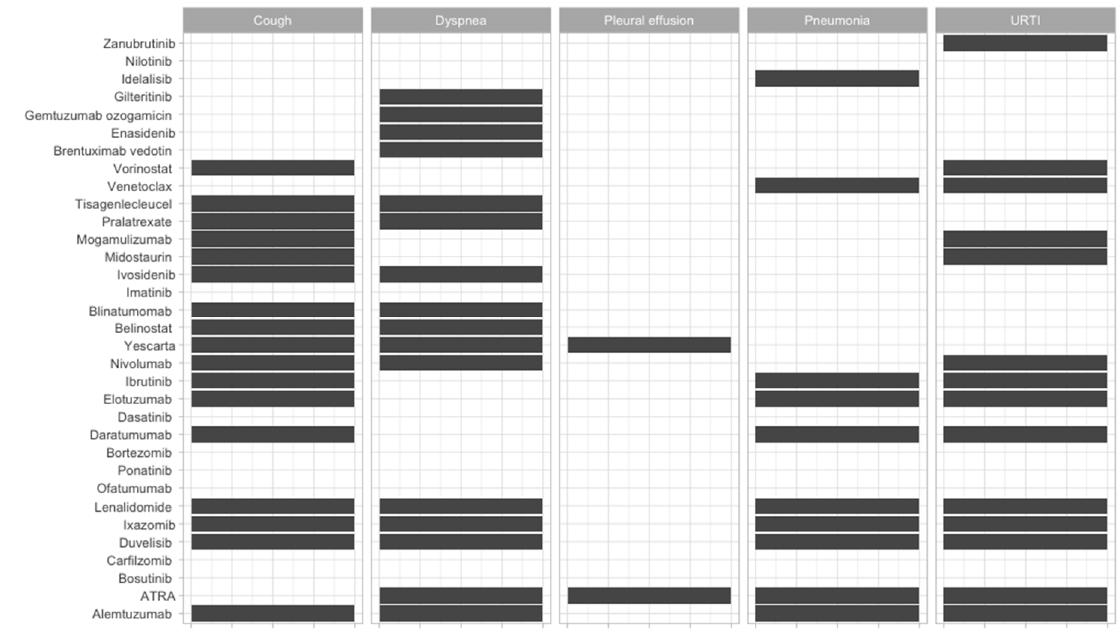
Figure 4. Respiratory side-effects of FDA-approved and non-approved drugs for hematological disorders. URTI = upper respiratory tract infection.